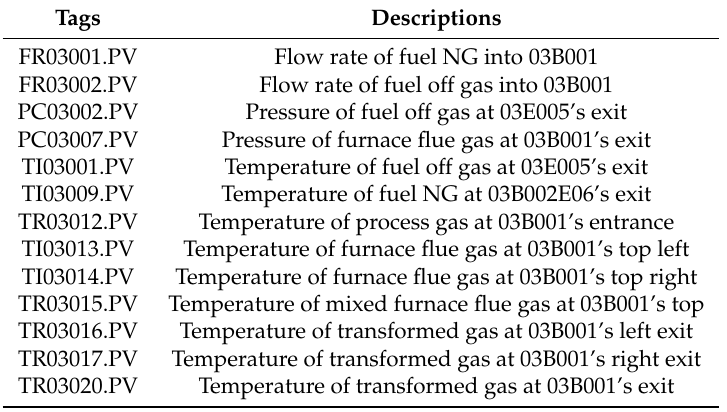
Table 4. Descriptions of process variables in the primary